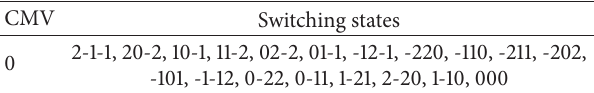
Table 3: Switching states with zero CMV. CMV